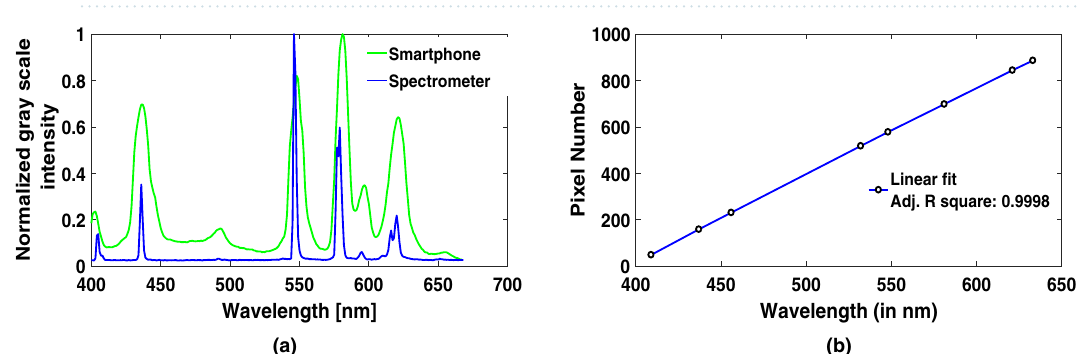
Figure 3. ( a ) Spectra of mercury lamp from smartphone and spectrometer, ( b ) Pixel v/s wavelength